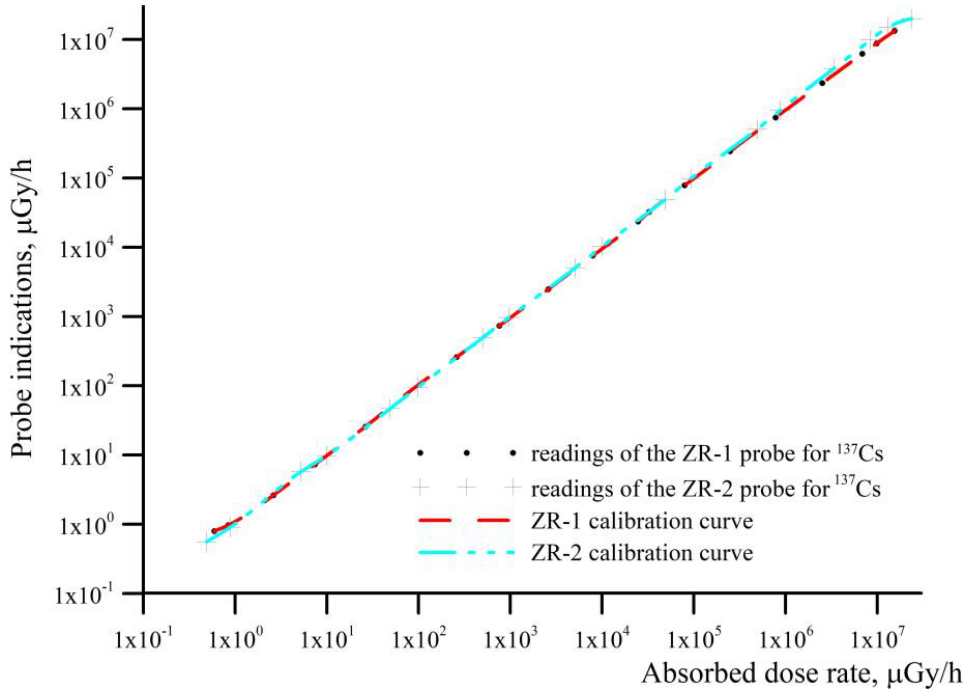
Figure 6. Registered dose rate of the ZR-1 and ZR-2 dosimetric probes as a function of the absorbed dose rate for the 137 Cs isotope.